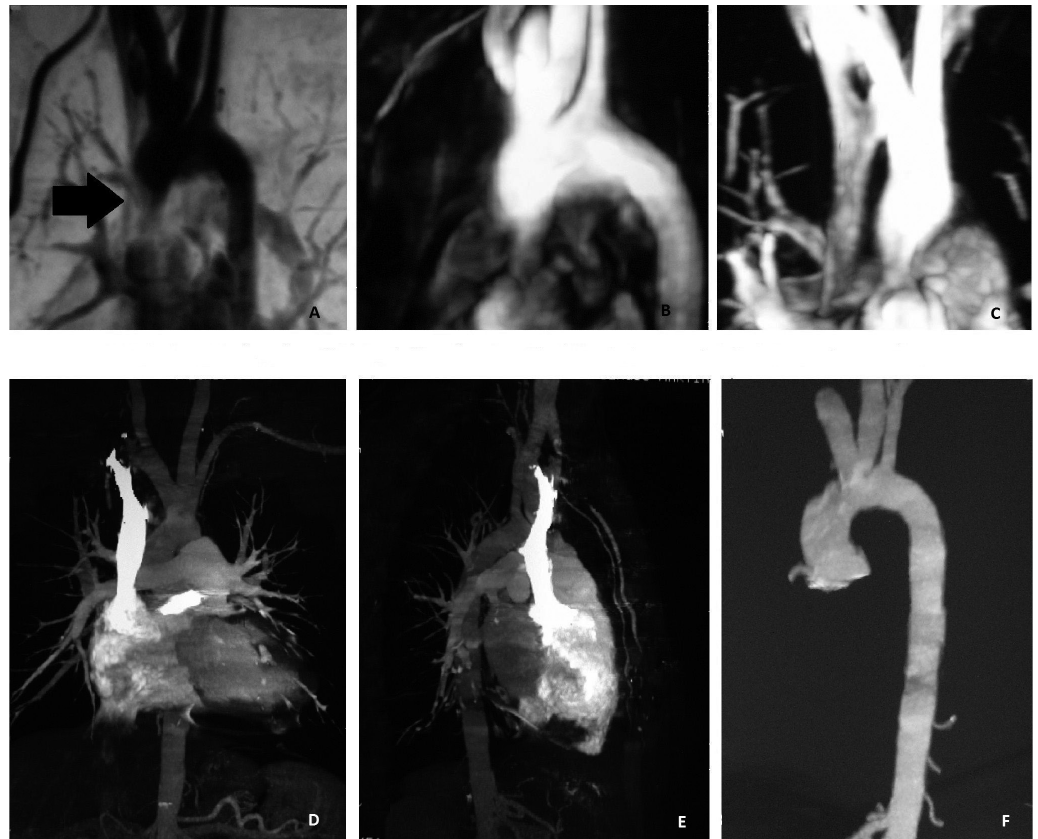
Fig 1 - CT angiography. Preoperative angiography. A: severe supravalvular aortic stenosis. B: anomalies of the great vessels with left common carotid artery originating from the BCT and hypoplastic left subclavian artery. C: Severe supravalvular aortic stenosis in another incidence. Post-operative images. D and E: good opening towards systemic output. F: external aspect of the